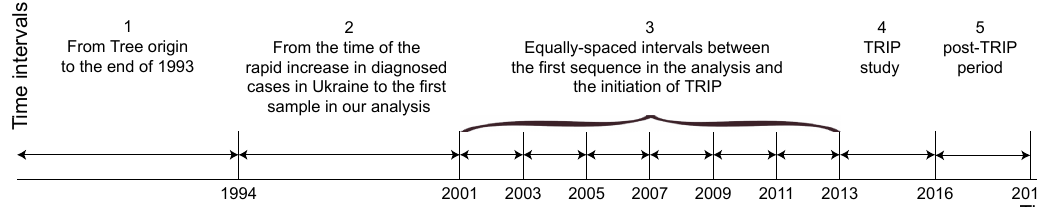
Figure 1. Time intervals specified for the birth-death skyline model (BDSKY) analysis.